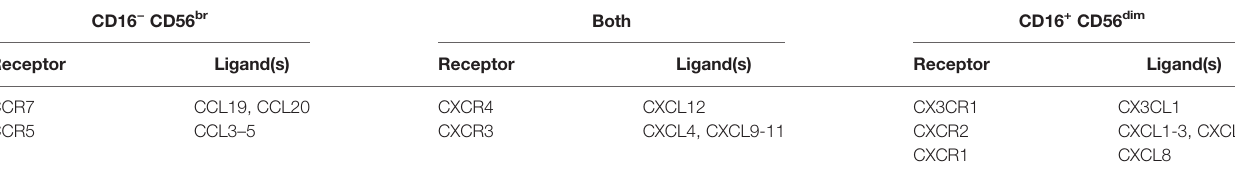
TABLE 2 | Chemokine receptor expression on human NK cell subsets, and their corresponding chemokine ligands. CD16 − CD56